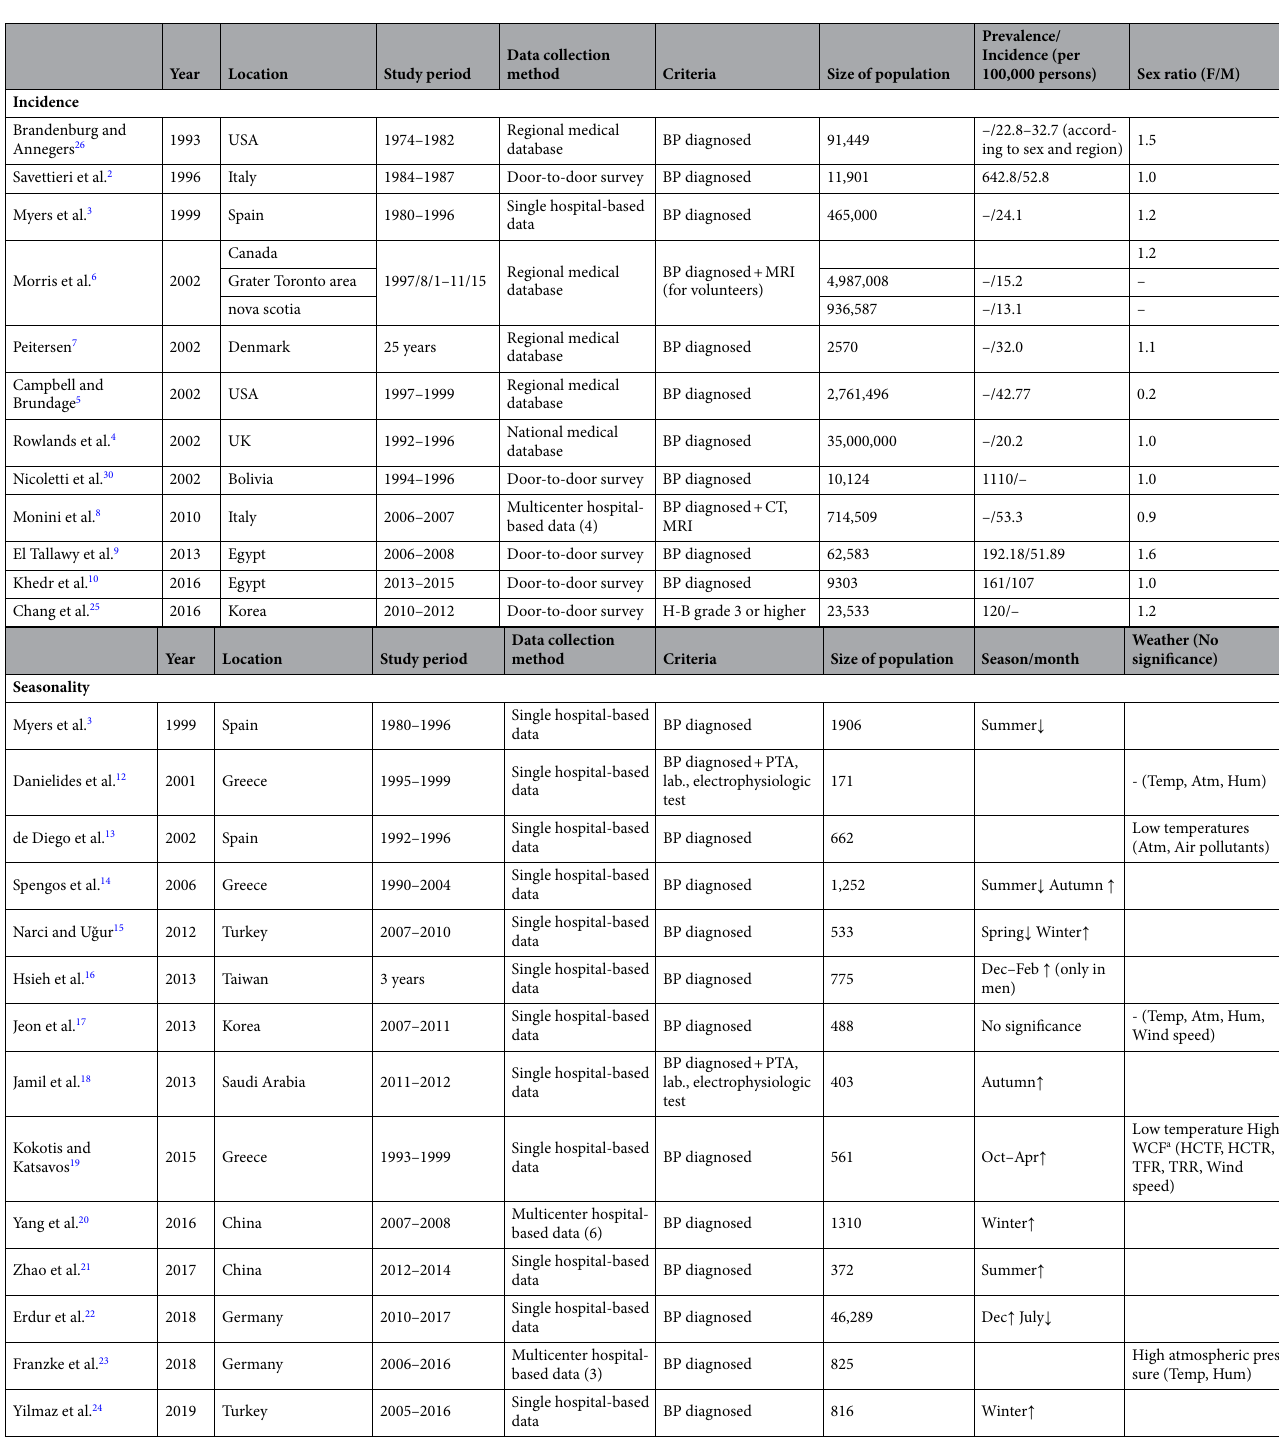
Table 4. Reported Bell’s palsy incidence and seasonality in studies conducted in the past three decades. BP Bell’s palsy, PTA pure tone audiometry, Temp temperature, Atm atmospheric pressure, Hum humidity,